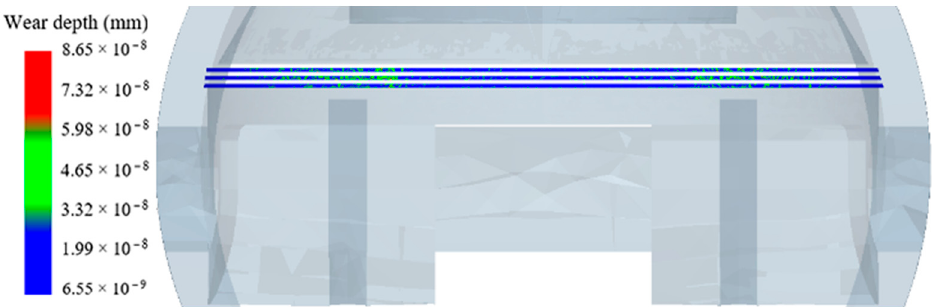
Figure 13. The 4 m/s wear depth cloud.